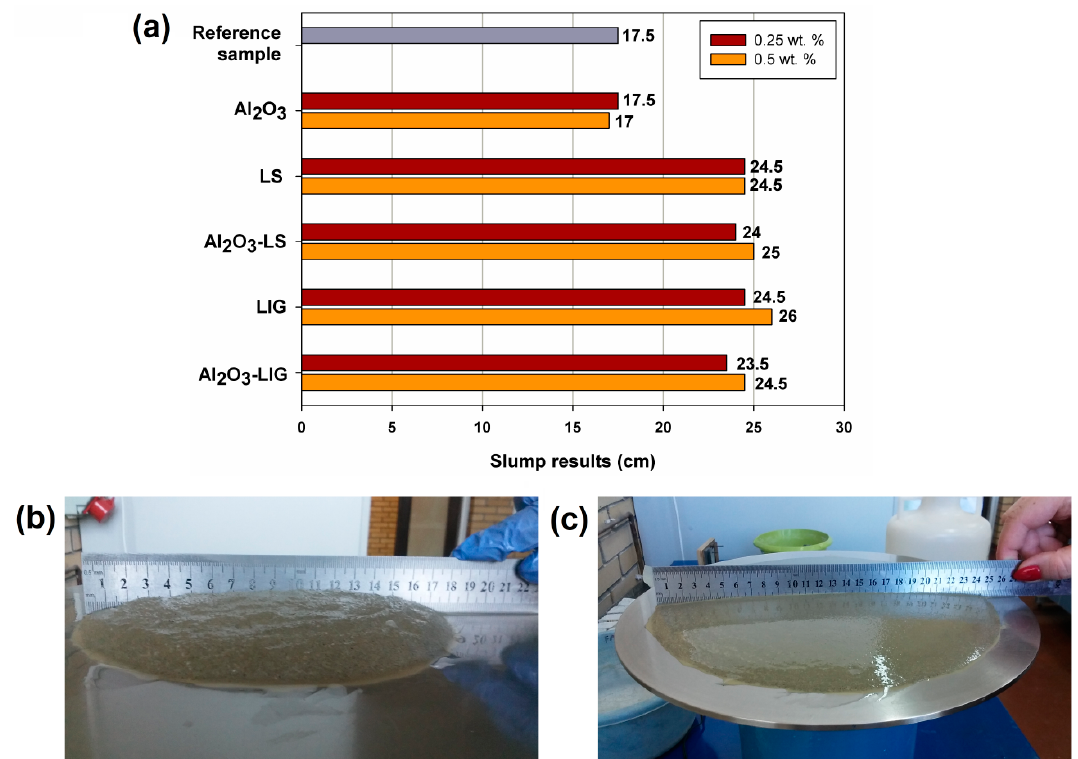
Figure 4. Slump test results for the analyzed samples ( a ) and digital photos of the slump for the reference sample ( b ) and the mixture containing 0.5 wt.% admixture of alumina-lignin hybrid material ( c ).